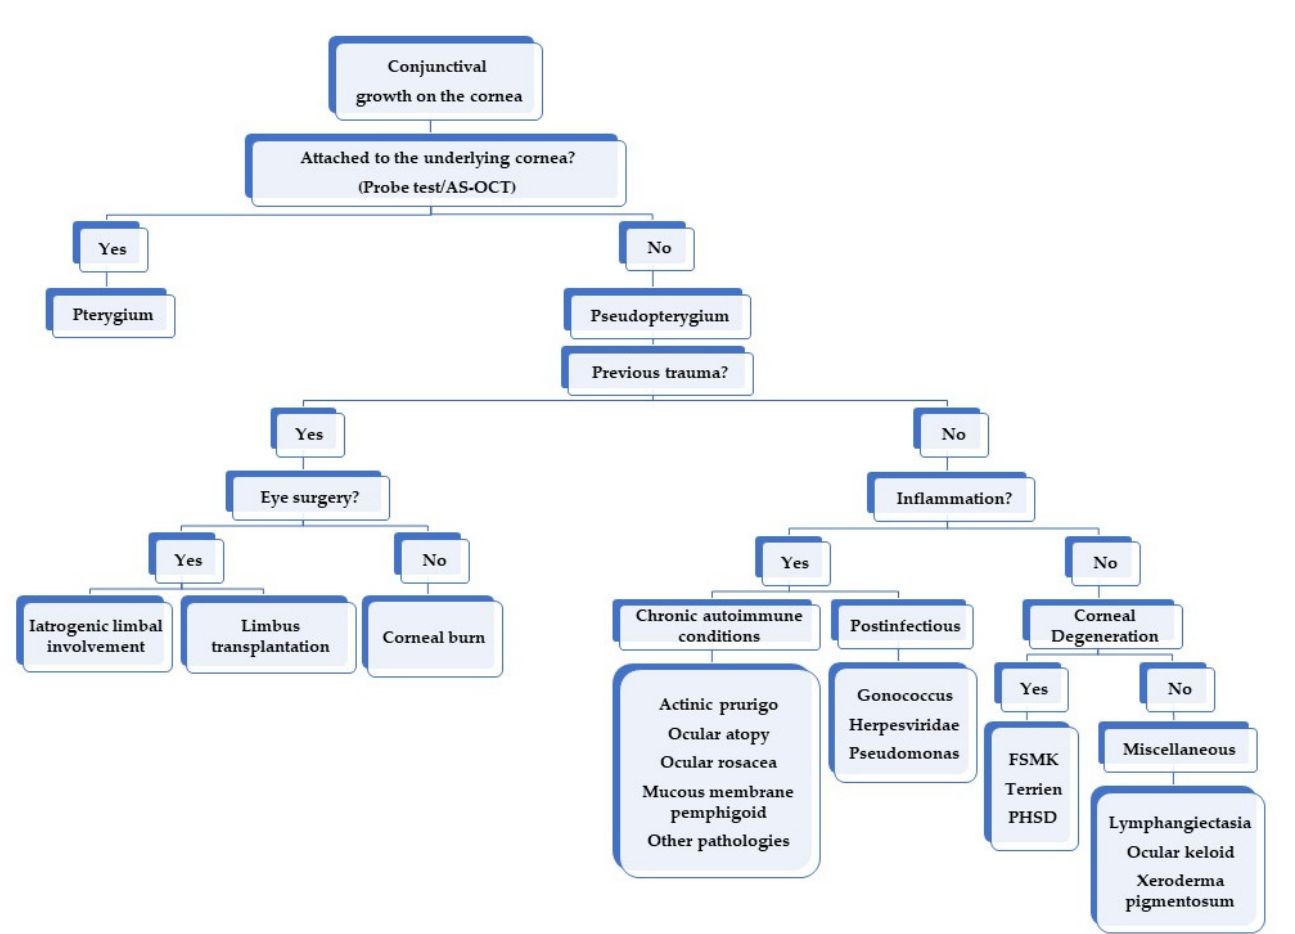
Figure 3. Algorithm approach to establish the etiological diagnosis of pseudopterygium. FSMK = Fuchs superficial marginal keratitis. PHSD = Peripheral hypertrophic subepithelial corneal degen- eration.